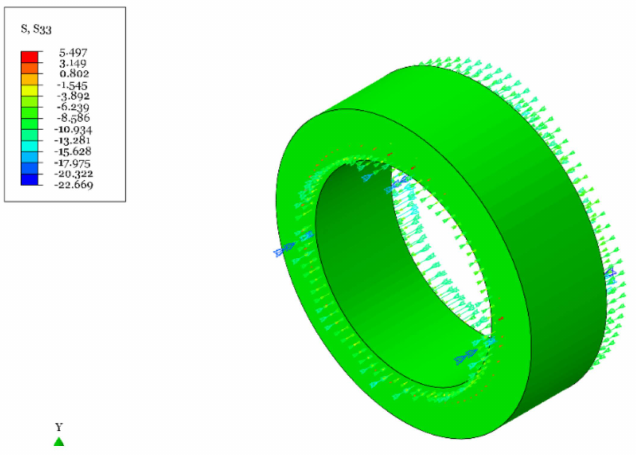
Figure 13. Test boss axial stress resulted from 200 Nm